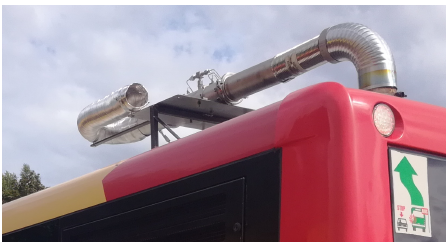
Figure 2. The emissions are measured at the tailpipe of the bus. A sampling probe is installed after the EFM, before guiding the exhaust gases towards the back of the